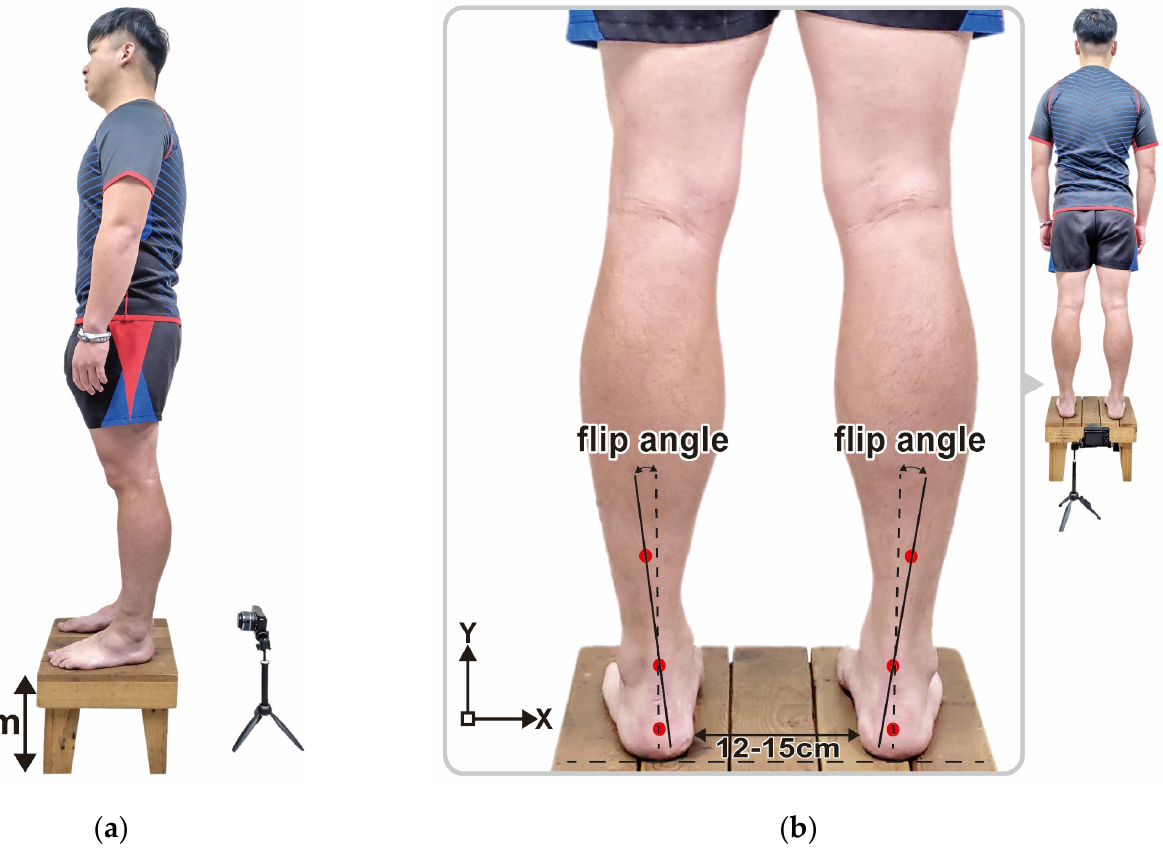
Figure 1. Schematic diagram of each participant in a static standing posture in ( a ) the lateral and ( b ) posterior view, coupled with positioning marks in the back of lower legs and measurement methods of the rearfoot alignment.